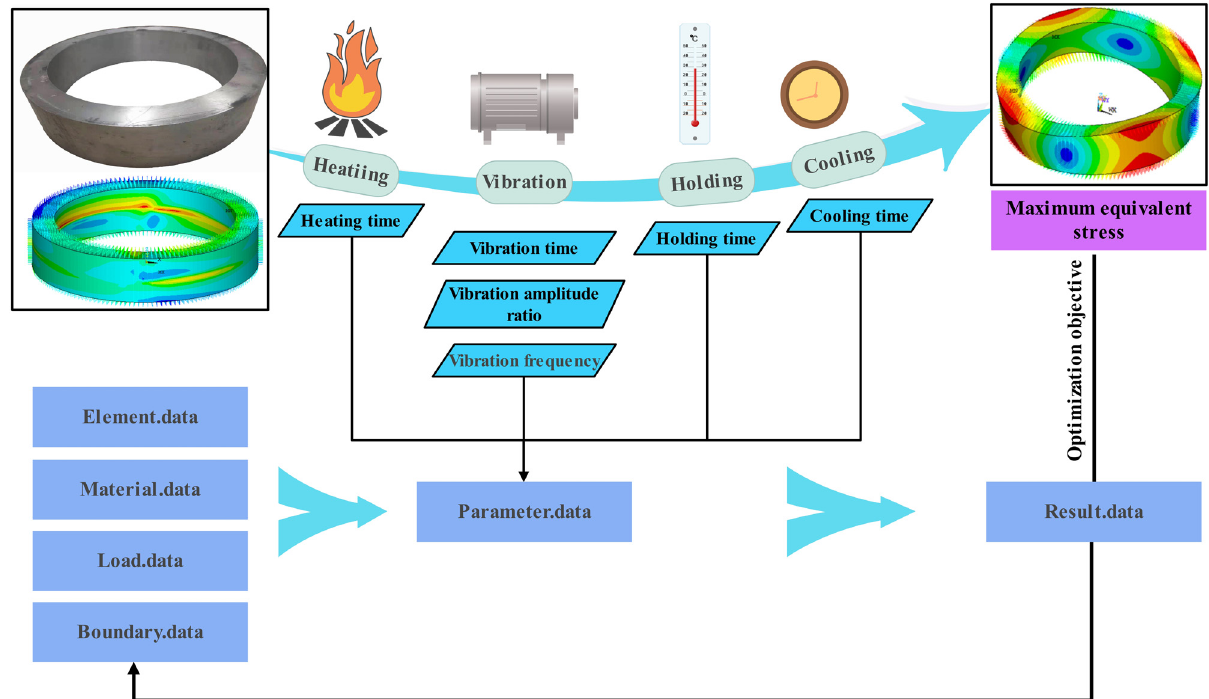
Figure 7: Optimization design process of TVSR